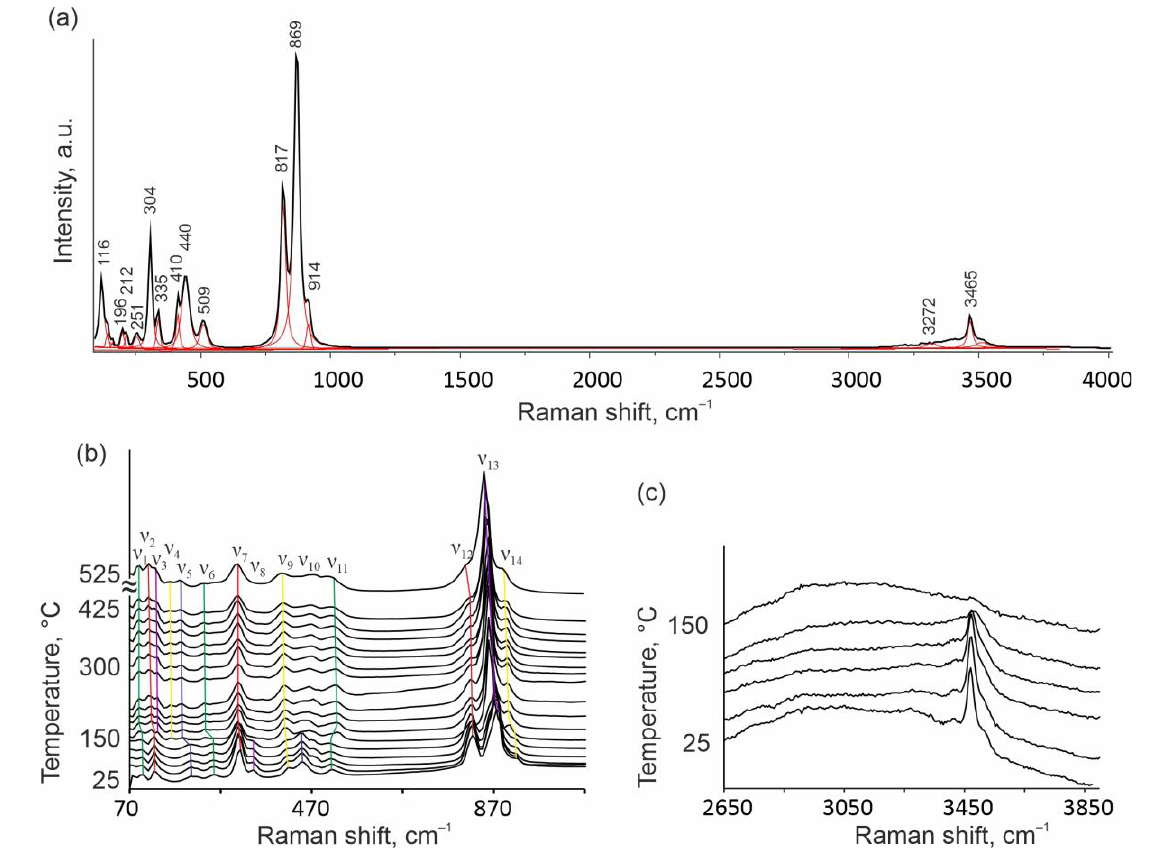
Figure 1. Raman spectra of BaAs 2 Zn 2 O 8 · H 2 O under ambient conditions from 70 to 4000 cm − 1 ( a ); at